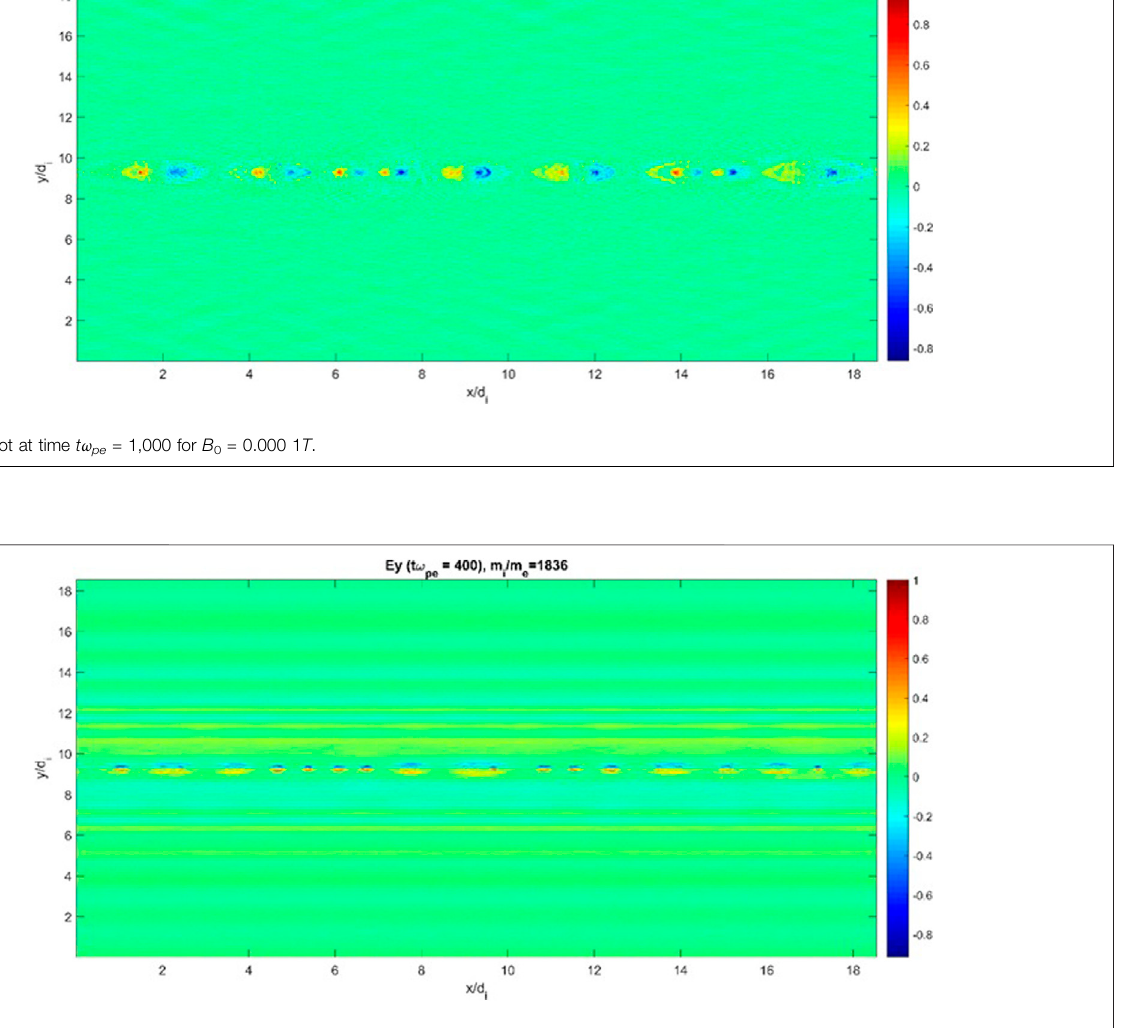
Frontiers in Astronomy and Space Sciences |